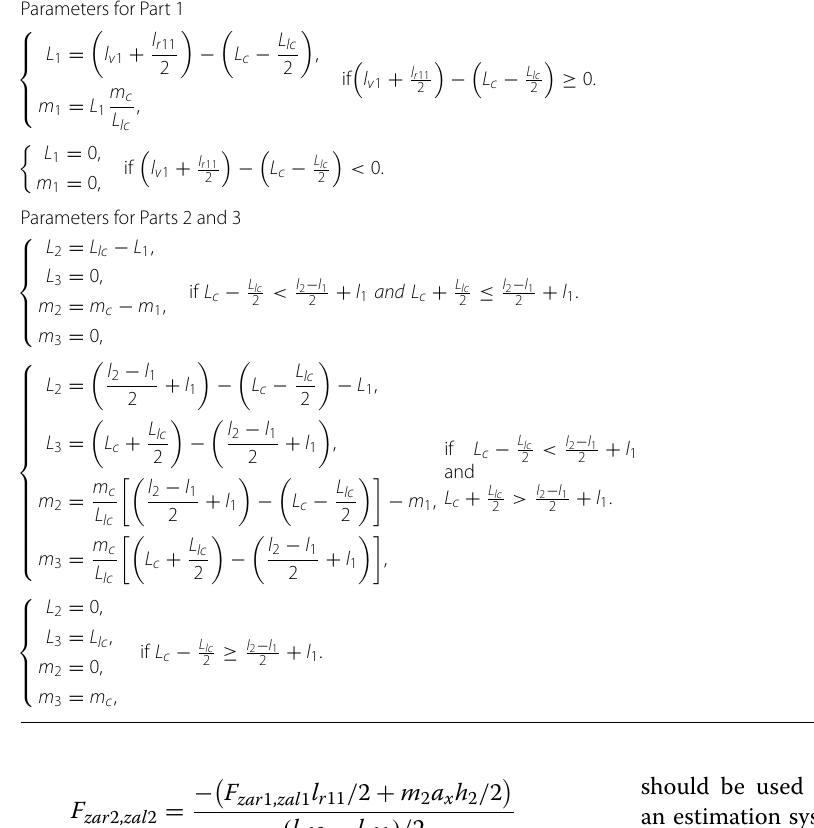
Table 1 Parameter design based on different loaded positions ( L Parameters for Part